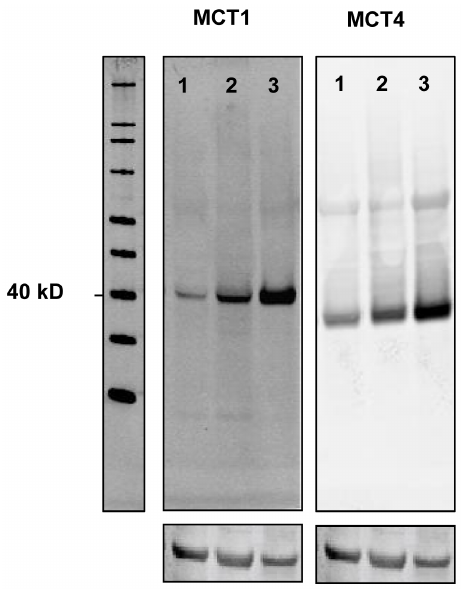
Figure 1. Western Blot of MCT1 and MCT4. In all cell lines investigated (A-549; lung adenocarcinoma, H661; large cell carcinoma, U-251 MG; neuronal glioblastoma) a protein band of approximately 40 kDa was detected corresponding to MCT1 and MCT4. Equal